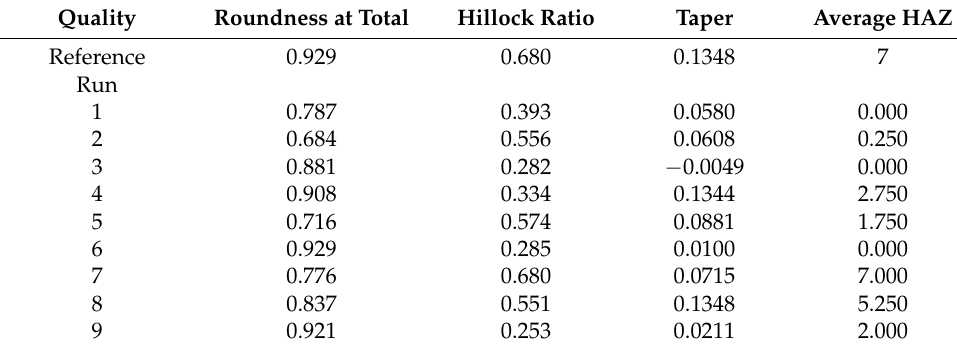
Table 4. Calculated results of the major multiple qualities.